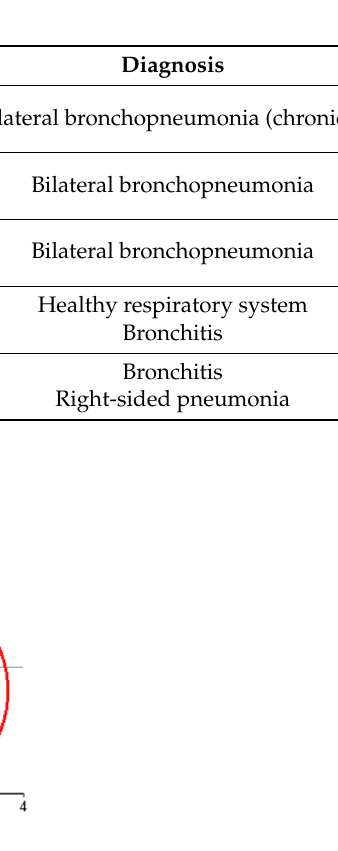
Figure 2. Classification of calves according to the clinical and laboratory indicators. The nasal mucus from calves was then analyzed with the piezoelectric sensor